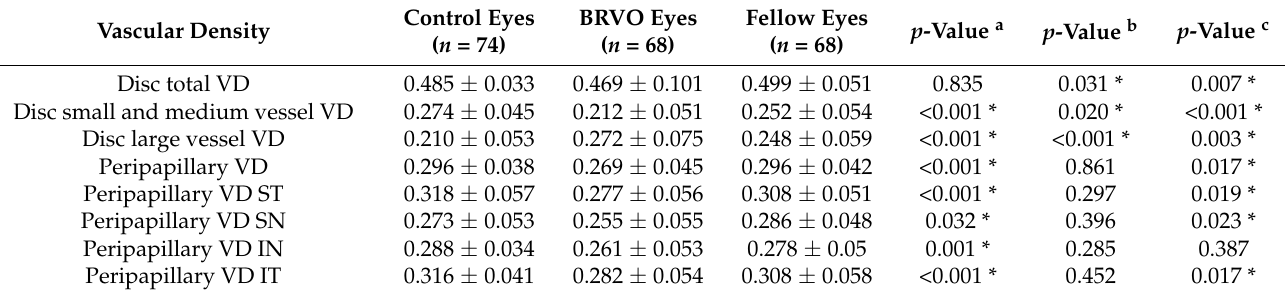
Table 3. Vessel densities of the